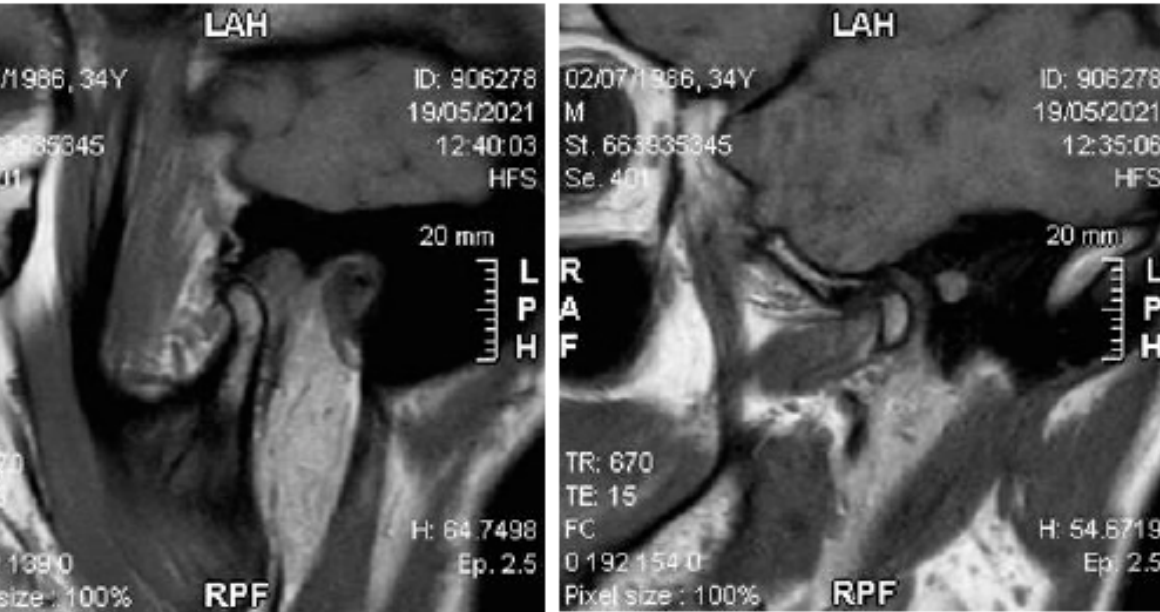
Figure 28. Surface electromyography. In the present case, the evaluation of cervical movements (BAIOBIT—Rivelo SRL, BTS Bioengineering group) showed a reduction in the amplitude of the extension movements of the head and bending on the right side (inclination) [19] (Figure 29).